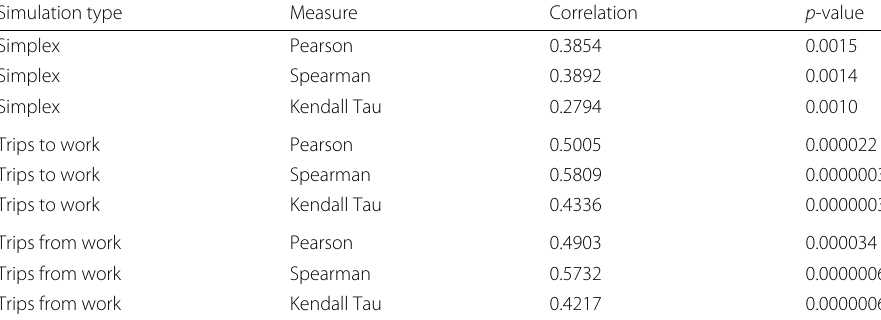
Table 11 Similarity and significance between the empirical rail line max usage and the max values of the simulated usage rates across all links on that line of all